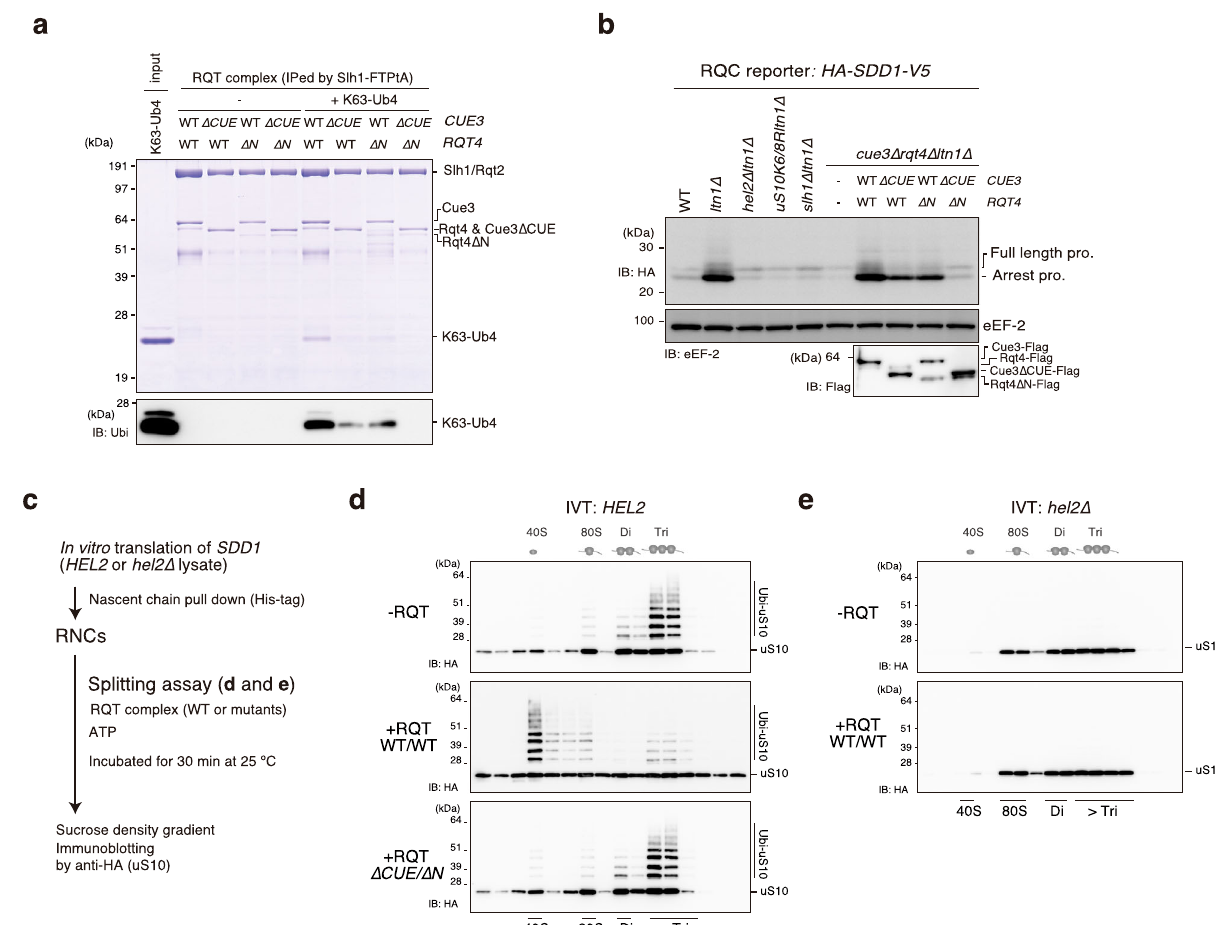
Fig. 6 | Decoding of K63-linked polyubiquitination is essential for the dis- assembly of the colliding ribosome by the RQT complex. a Pull-down assay of the trimer RQT complex with the K63-linked tetraubiquitin chain. The RQT com- plex was immobilized on IgG magnetic beads and mixed with the K63-linked tet- raubiquitin chain. After binding and washing steps, the proteins in the fi nalelution were separated by 10% Nu-PAGE and detected by CBB staining or immunoblotting using an anti-ubiquitin antibody. b Immunoblotting of the HA-Sdd1-V5 reporter peptide expressed in the deletion strains for RQT- and RQC-related